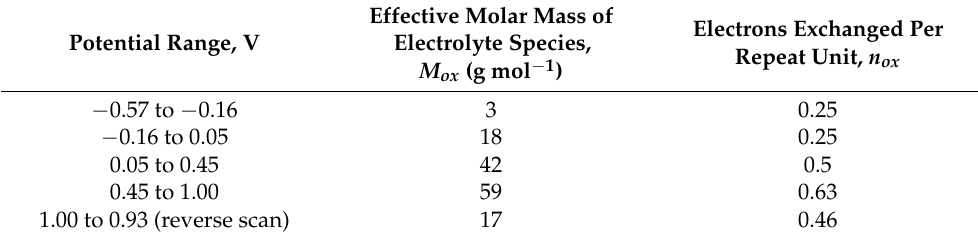
Table 3. Effective molar mass of electrolyte species, M ox , and the number of electrons per re- peat unit, n , sequentially exchanged during voltammetric oxidation of poly-[NiAmben] in 0.05 M Et 4 NBF 4 /DCE at 0.01 V s − 1 scan